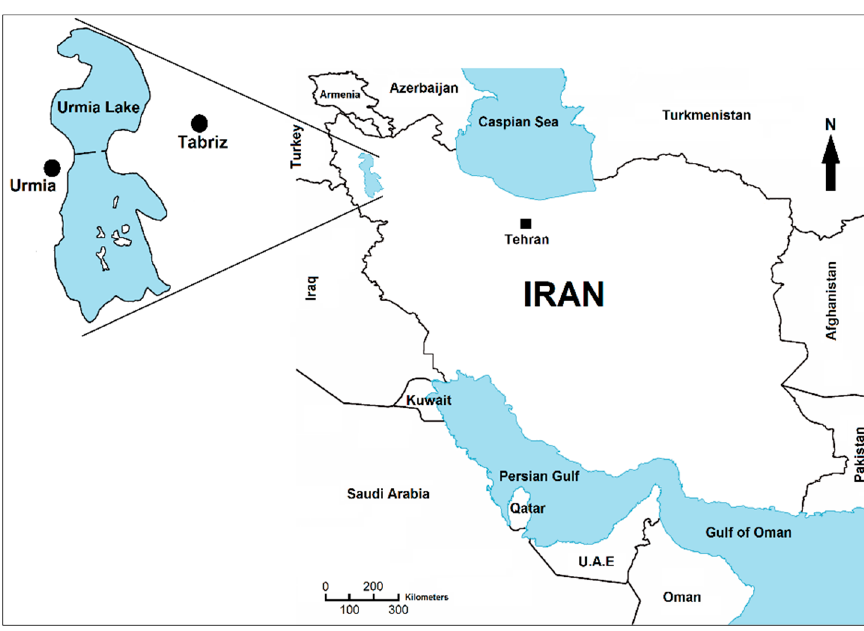
Figure 1. Geographical localization of Urmia Lake in the northwestern of Iran.